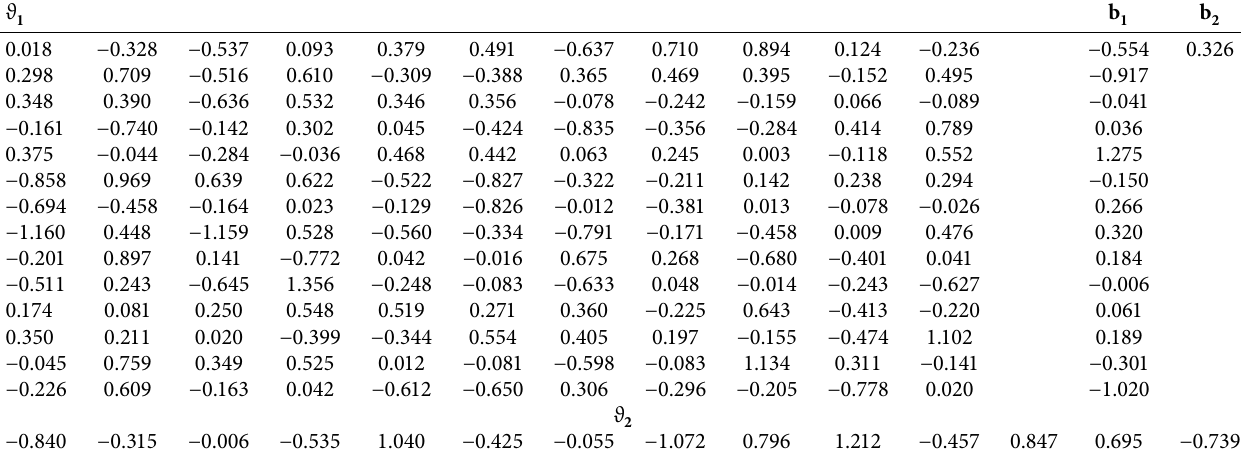
Table 10: The weight parameters of the ANN-BAT-1L (14) network.